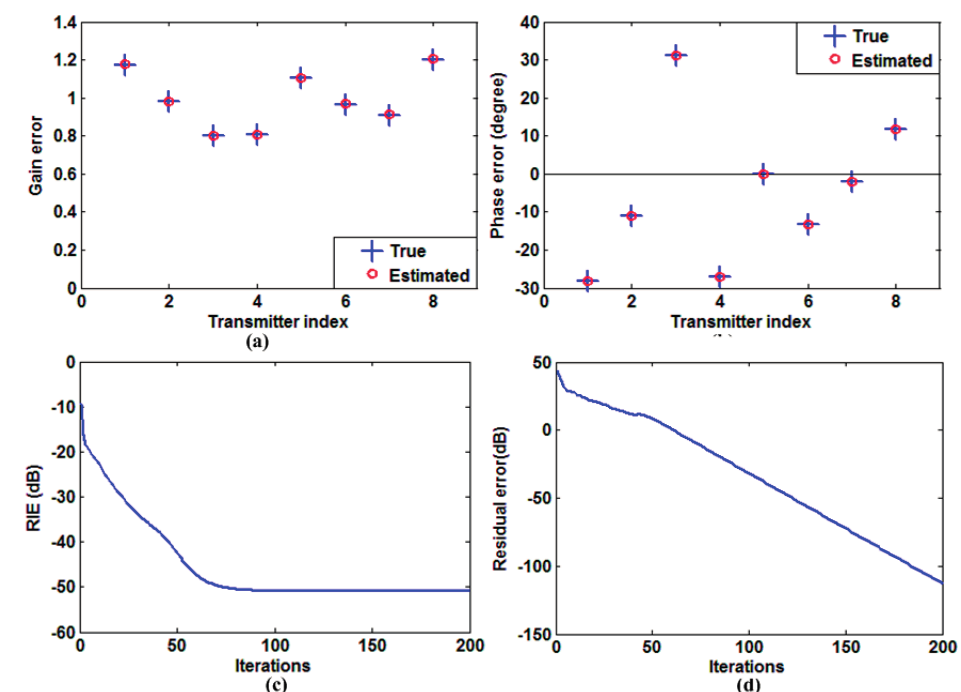
Figure 3. Auto-calibration performance. ( a ) Estimated and true gain error; ( b ) Estimated and true phase error; ( c ) RIE versus the number of iterations; ( d ) Residual error versus the number of